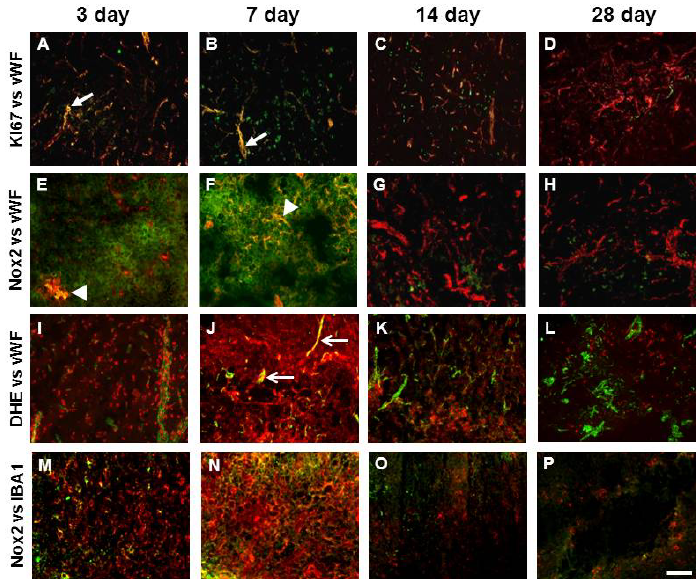
Figure 6. Nox2 immunohistochemistry in the stroke affected cortex is associated with proliferating blood vessels in addition to inflammatory cells. Merged immunofluorescent images of vWF labelled blood vessels (red) throughout the stroke affected cortex up to 28 days after ET-1 induced stroke co-localised with: the proliferation marker Ki67 (green) ( A – D ); a Nox2 antibody gp91Phox (green) ( E – H ); and the superoxide indicator DHE ( I – L ). Co-localisation (yellow) for Ki67 can be observed between 3 and 14 days after stroke ( A and B , arrows) with little overlap observed by 28 days ( D ). Nox2 and vWF double labelling (yellow) can be seen 3 and 7 days after stroke ( E and F , arrow heads) with little overlap detected beyond this time. DHE and vWF are also observed to co-localise at 3 and 7 days after stroke ( I and J , open arrows). Merged immunofluorescent images of Nox2 (green) co-localisation with rabbit polyclonal IBA1 marker for activated microglia (red) ( M – P ). Scale bar = 100 μ